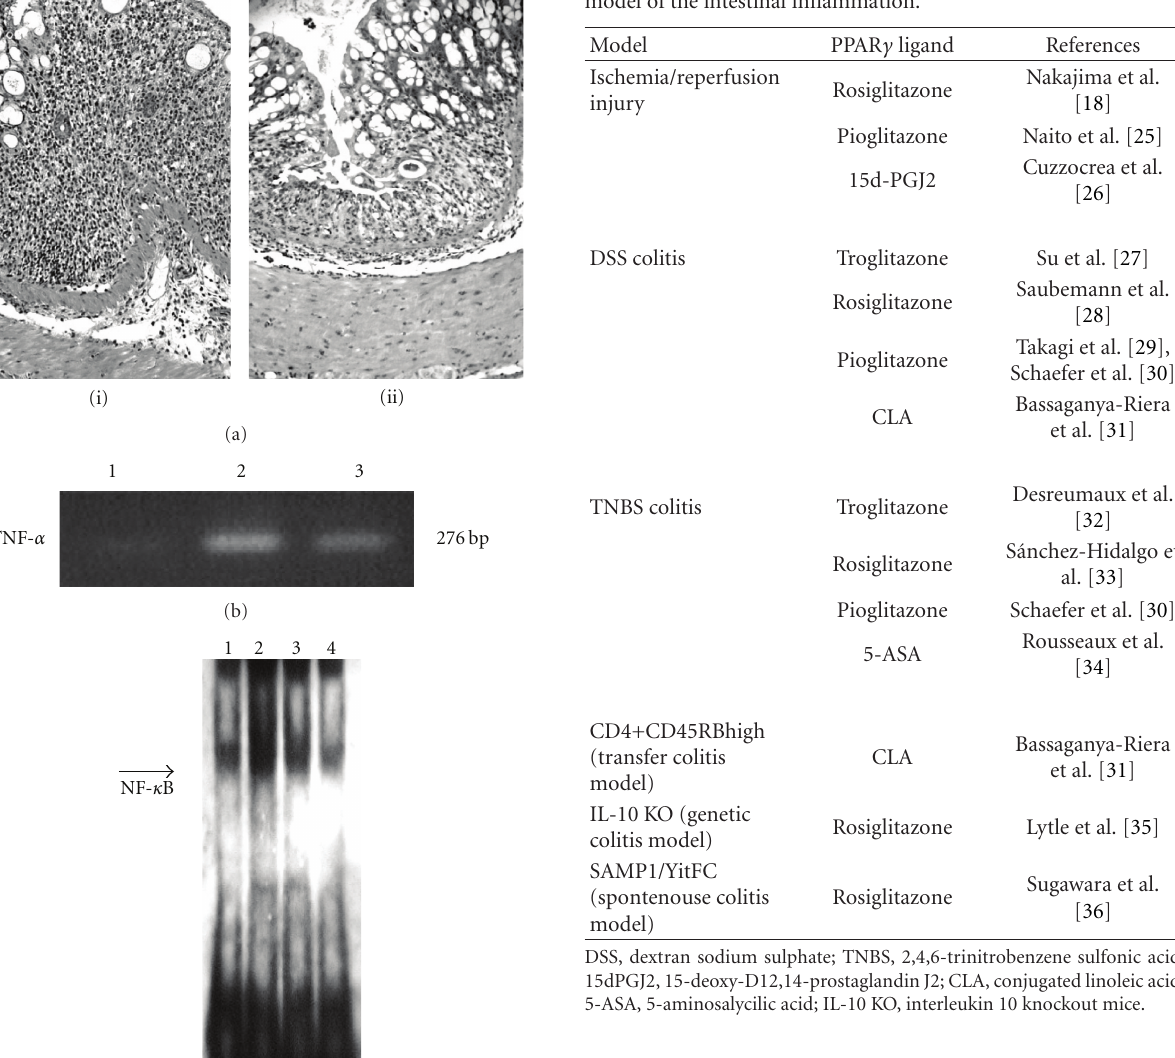
Table 2: Cytoprotective properties of PPAR γ in experimental model of the intestinal